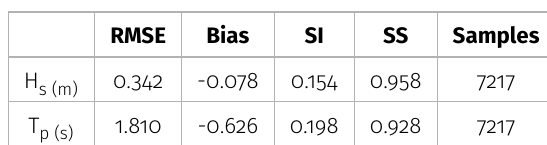
Table II. Statistical parameters responsible to quantify the model